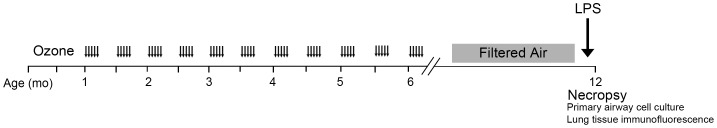
Experimental timeline for postnatal episodic ozone exposure and in vivo LPS challenge in juvenile monkeys.Starting at 1 month of age, infant rhesus monkeys (n = 8) were exposed to 11 cycles of ozone. Each cycle consisted of ozone exposure for 5 days (0.5 parts per million at 8 h/day for 6 months (small arrows)) followed by 9 days of filtered air. At the end of 11 exposure cycles, animals were housed in filtered air until 1 year of age. Control animals (n = 9) were housed in filtered air until 1 year of age. An aerosolized LPS challenge via face mask was given to the ozone-exposed and the filtered air-control animals at 1 year of age (n = 4 each group; marked by the large arrow in figure). All animals were necropsied within 24 h of in vivo LPS; lung tissues were collected for cell culture and histology.